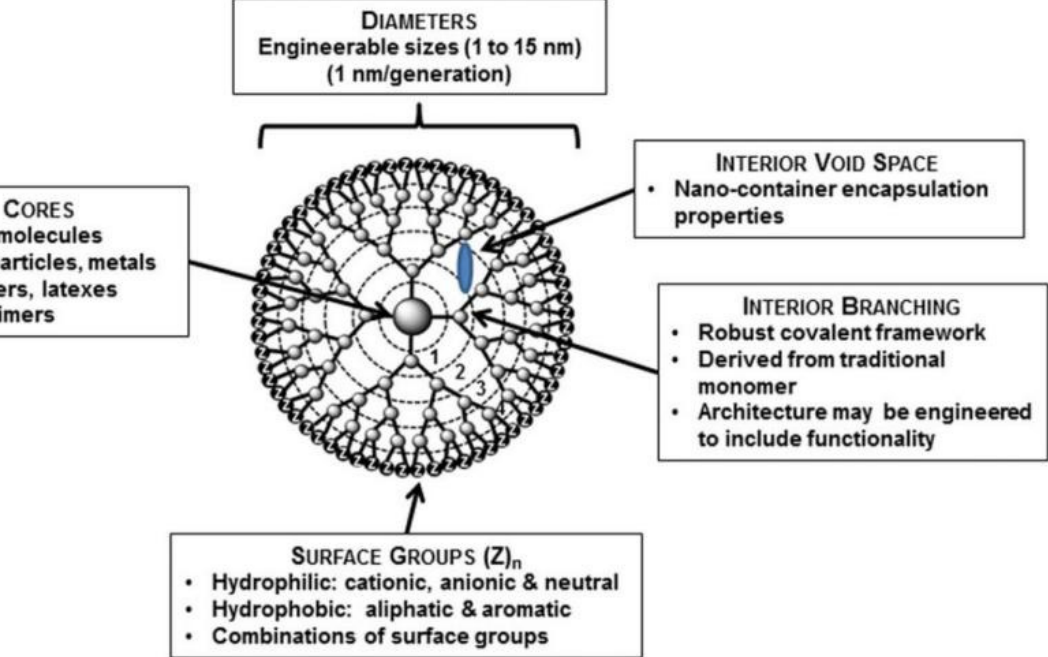
Figure 6. Schematic diagram of a G-4 dendrimer containing four generations (branching points), as indicated by generation numbers. Reprinted/adapted with permission from Ref. [101]. 2015, Chauhan, A.S.